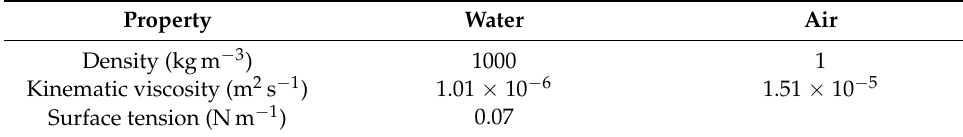
Table 1. Transport properties of the fluid phases.